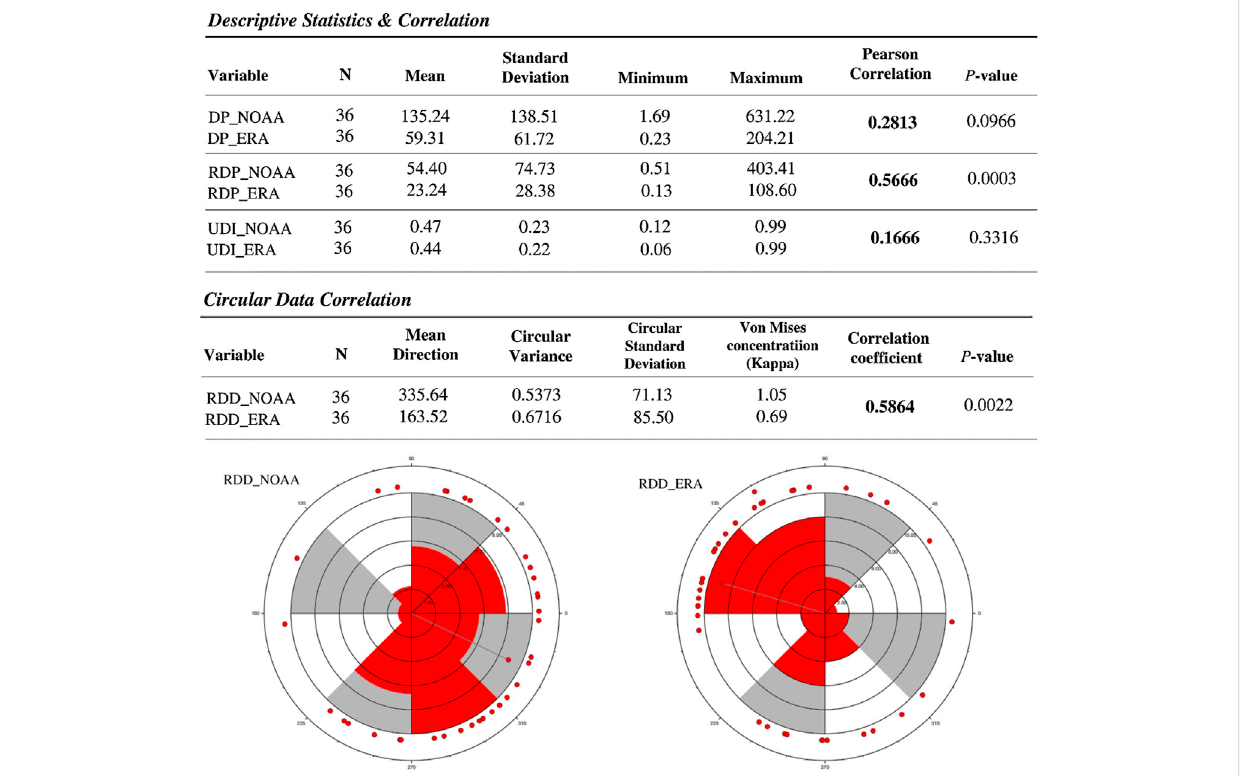
FIGURE 6 Sand Roses for 36 National Oceanic and Atmospheric Administration (NOAA) weather stations in relation to ERA5 grid points. Sand Rose follow the location of wind roses depicted in Figure 5. The green, red, and blue color of the information window below each rose stands for Turkmenistan, Uzbekistan,andthestationslocatedinKazakhstan,respectively.Thecircularcorrelationbetweentwovariableresultantdriftvectorsis0.5864,revealinga low to moderate